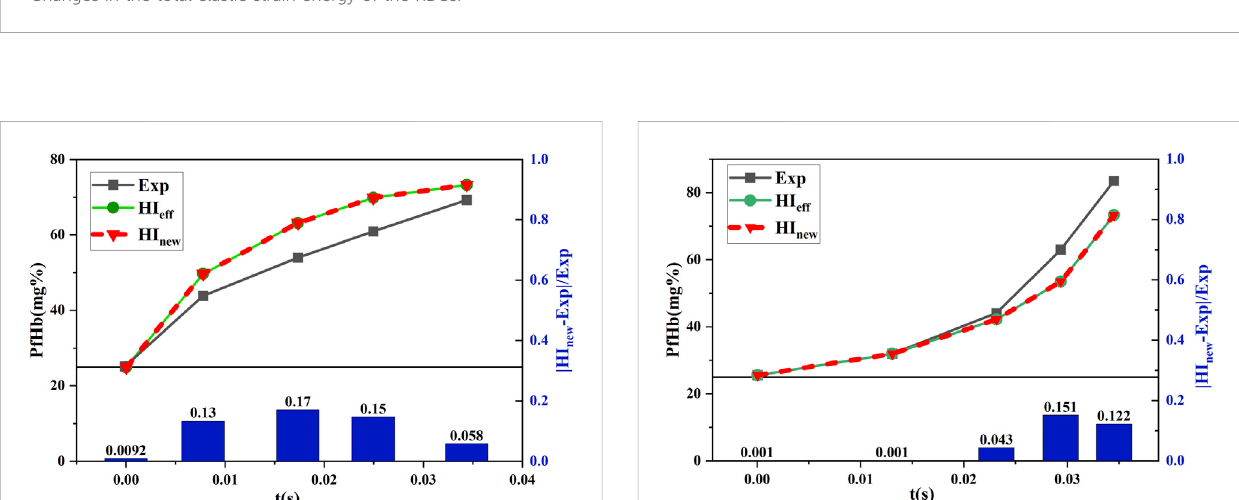
FIGURE 8 Changes in the total elastic strain energy of the RBCs.